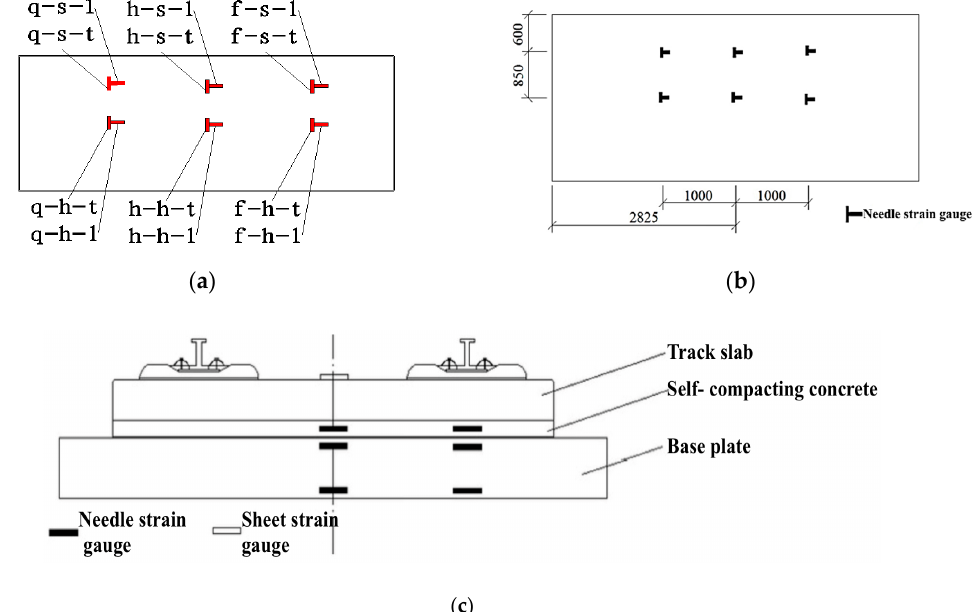
Figure 4. Layout of strain gauges. ( a ) Schematic diagram of corresponding symbols; ( b ) layout drawing of needle strain gauge; ( c ) cross-sectional view of strain gauge layout. In (a), “q”, “f”, “h”, “s”, “l”, “t”, respectively, represent longitudinal quarter, longitudinal three quarters, longitudinal plate middle lateral plate middle, lateral plate edge, longitudinal, and lateral.